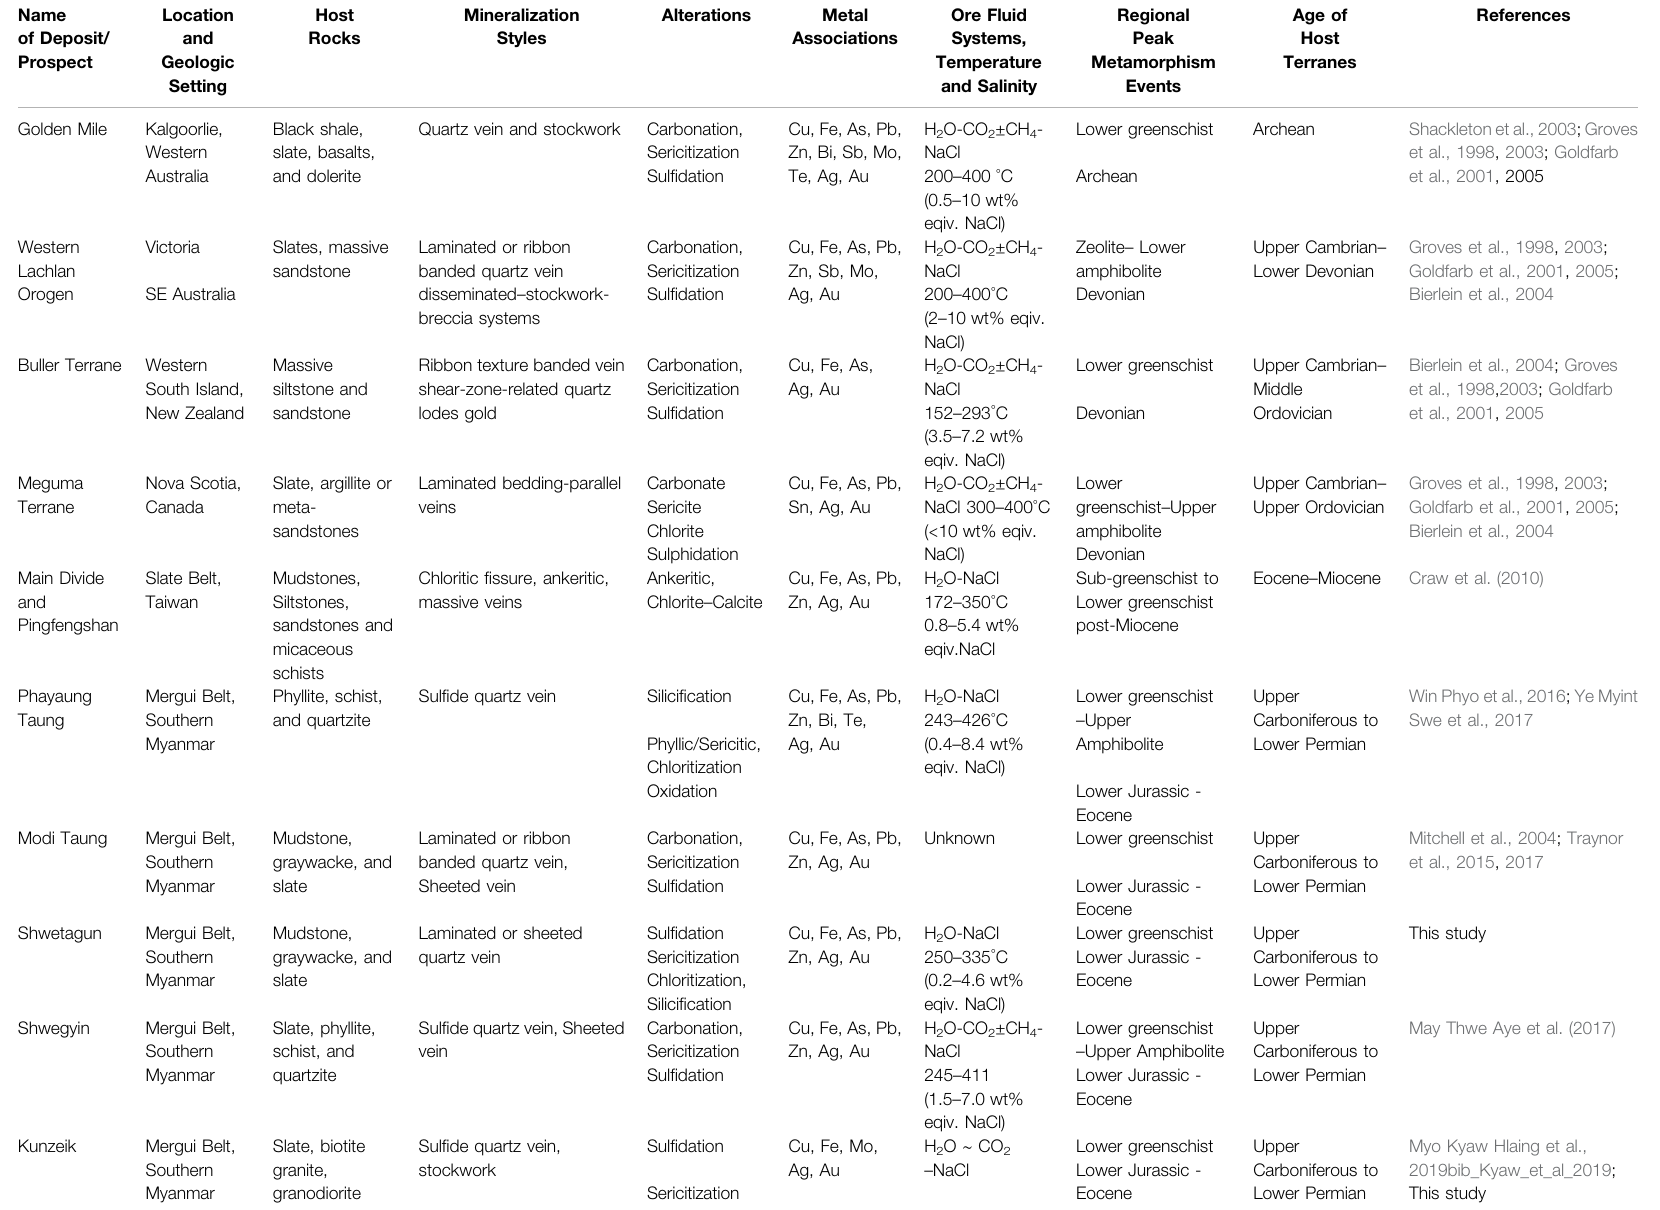
TABLE 3 | Comparative table showing characteristics of the Shwetagun, Kunzeik and Zibyaung deposits with other orogenic gold deposits in Myanmar and worldwide. Name of